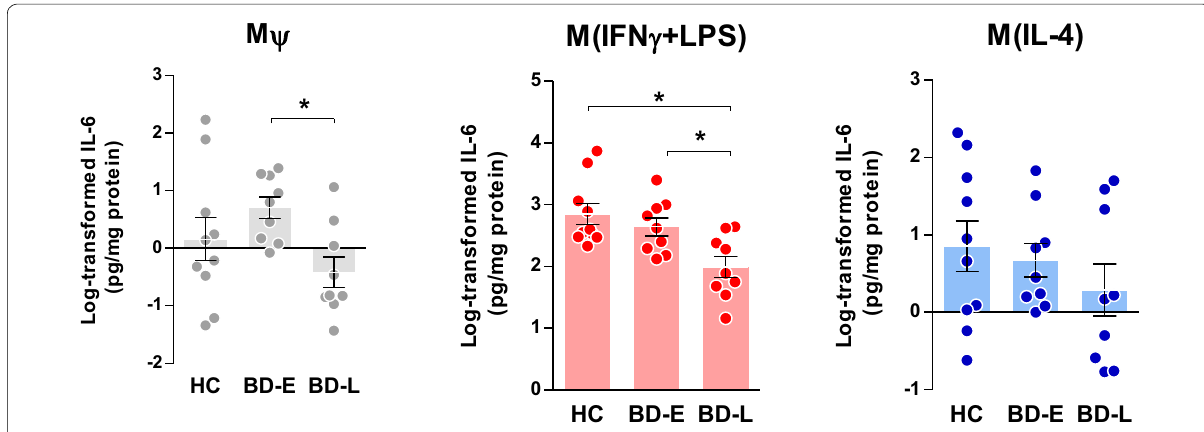
Fig. 4 Levels of IL‑6 secreted by different phenotypes of macrophages derived from individuals at early (E)‑ and late (L)‑stage BD and healthy controls (HC). One‑way ANOVA followed by Tukey post hoc, data expressed by mean